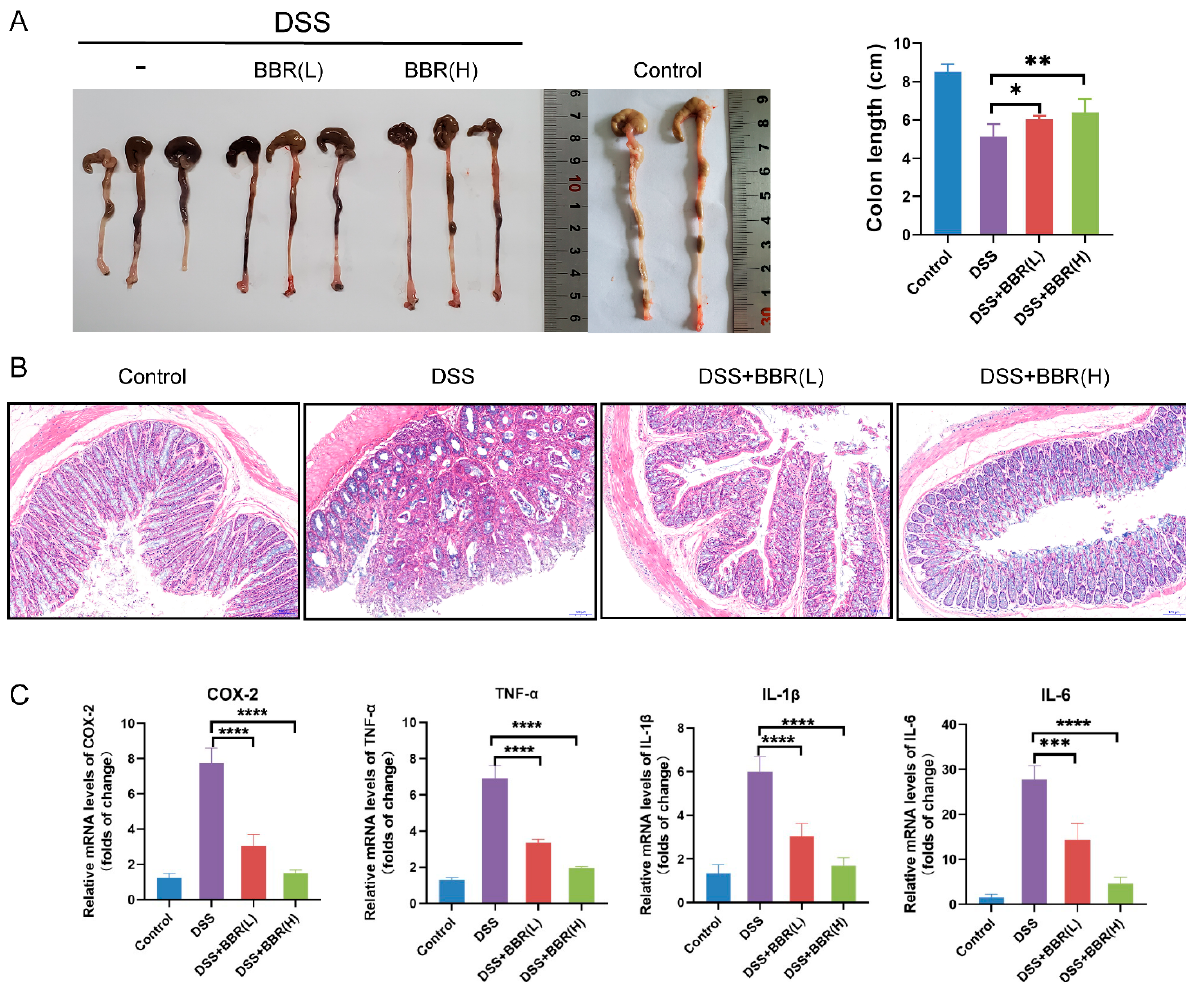
Figure 3. The effect of pre-administration of BBR on DSS-induced colon inflammation. ( A ) Repre- sentative photograph and quantitative result showing the length of colon in each group ( n = 6–10). ( B ) Histopathological changes were examined by hematoxylin-eosin (H&E) staining ( n = 6–10); scale bars = 50 µ m. ( C ) The transcriptional levels of cyclooxygenase (COX-2), tumor necrosis factor (TNF- α ), interleukin (IL-1 β ), and IL-6 in colon tissues detected by quantitative real-time polymerase chain reaction (RT-qPCR). β -actin was used as internal control to normalize target genes transcription, and relative mRNA expression was calculated by the 2 − ∆∆ Ct method ( n = 5). Data are presented as mean ± SEM of the indicated number of independent experiments. “*” p < 0.05, “**” p < 0.01, “***” p < 0.001, “****” p < 0.0001 vs. model group (DSS